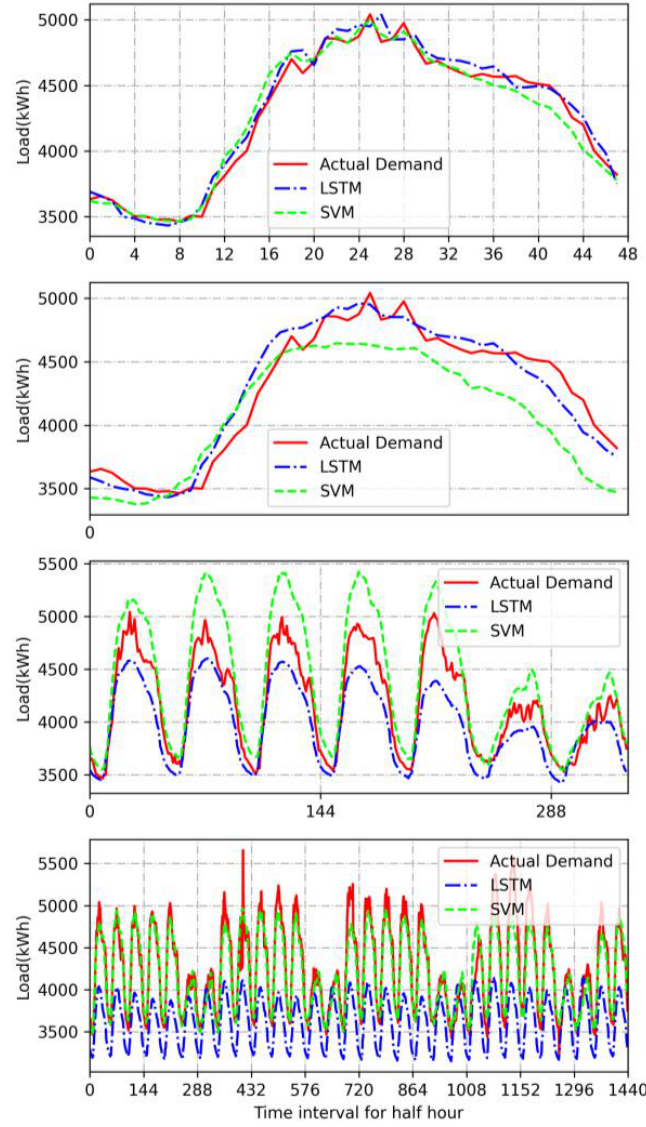
Figure 12. Comparison of prediction results in four prediction scenarios.